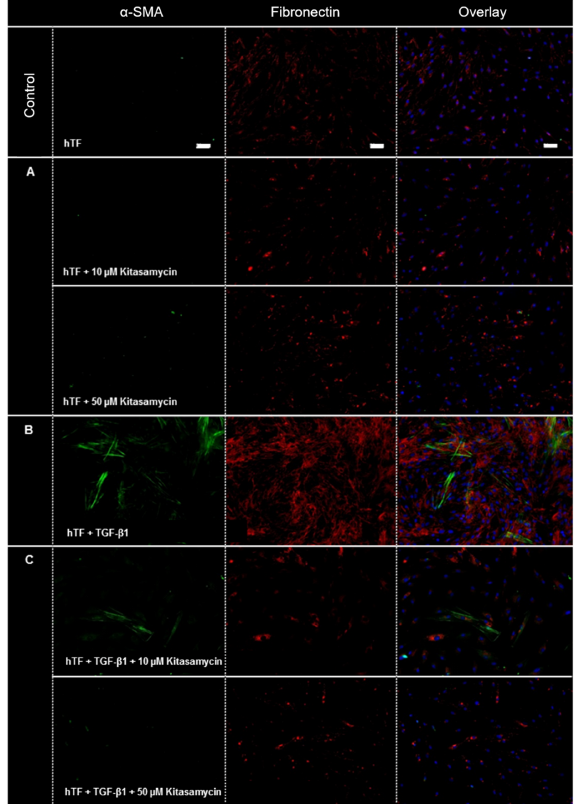
Figure 2. Immunofluorescence ‐ based in vitro evaluation of the antifibrotic effect of kitasamycin (KM) in a TGF ‐β 1 ‐ mediated fibrotic cell culture model. Immunofluorescence images of α‐ SMA (green) and fibronectin (red) in human Tenon’s fibroblasts (hTFs) treated with KM ( A ) (hTFs + 10 and 50 μ M KM), ( B ) TGF ‐β 1 (hTFs + TGF ‐β 1) and ( C ) the combination of TGF ‐β 1 and KM (hTFs + TGF ‐β 1 + 10 and 50 μ M KM) for 48 h. Untreated hTFs served as controls. Cell nuclei were stained with DAPI (blue). Measurement bar: 50 μ m.